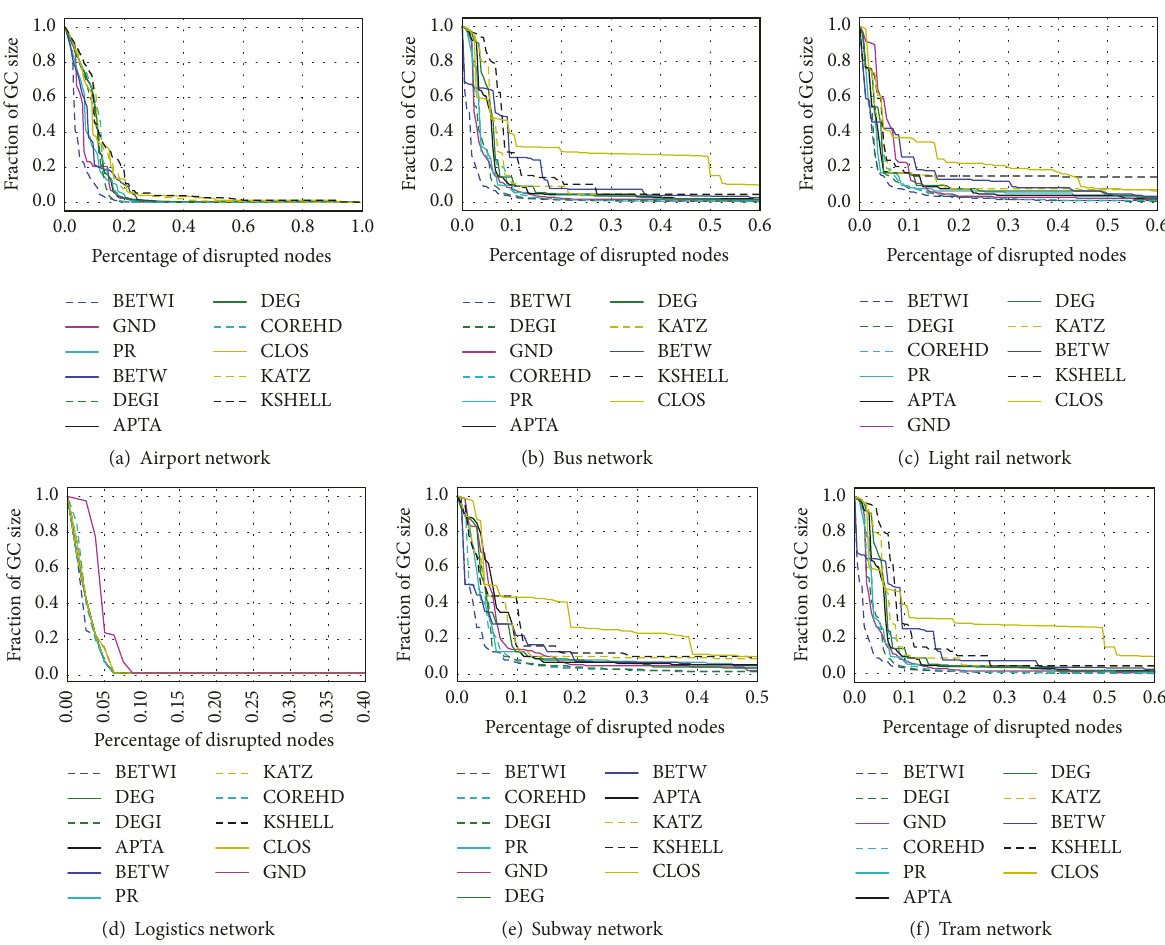
Figure 5: Comparison of robustness curves for different attack heuristics on six transportation networks, as described in Appendix.